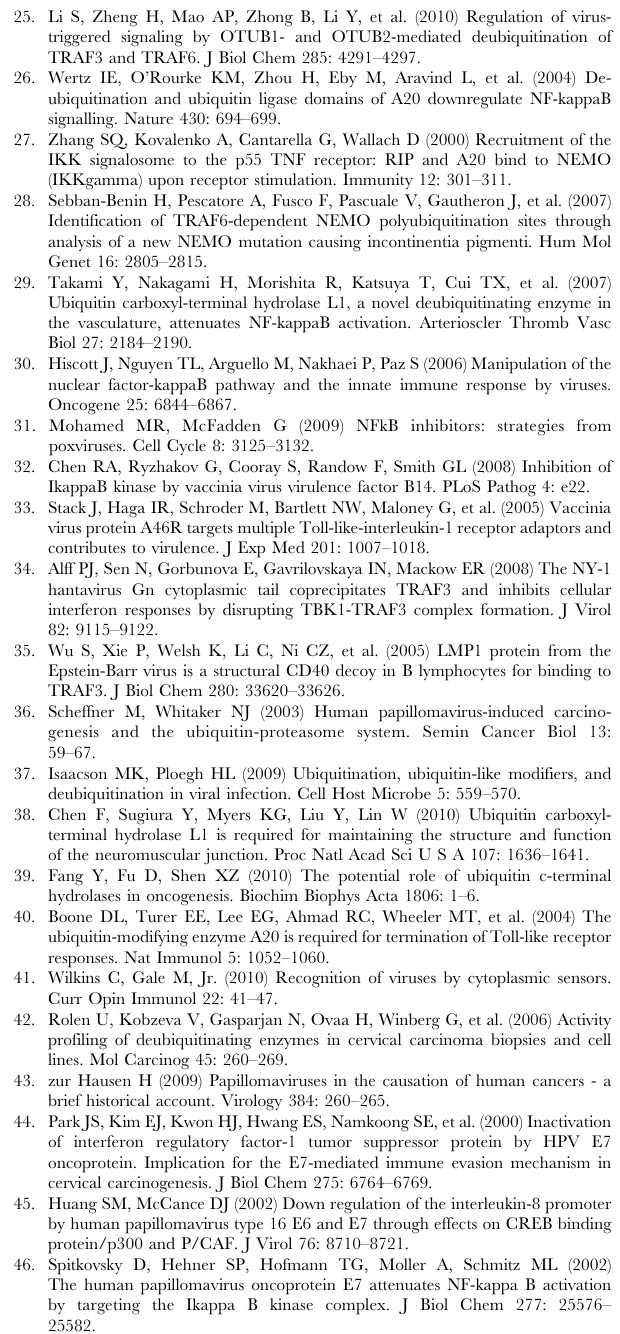
Table S1 Enrichment of pathways between HPV-posi- tive and uninfected keratinocytes as analyzed by Inge- nuity Pathway Analysis (IPA). (DOC) Author